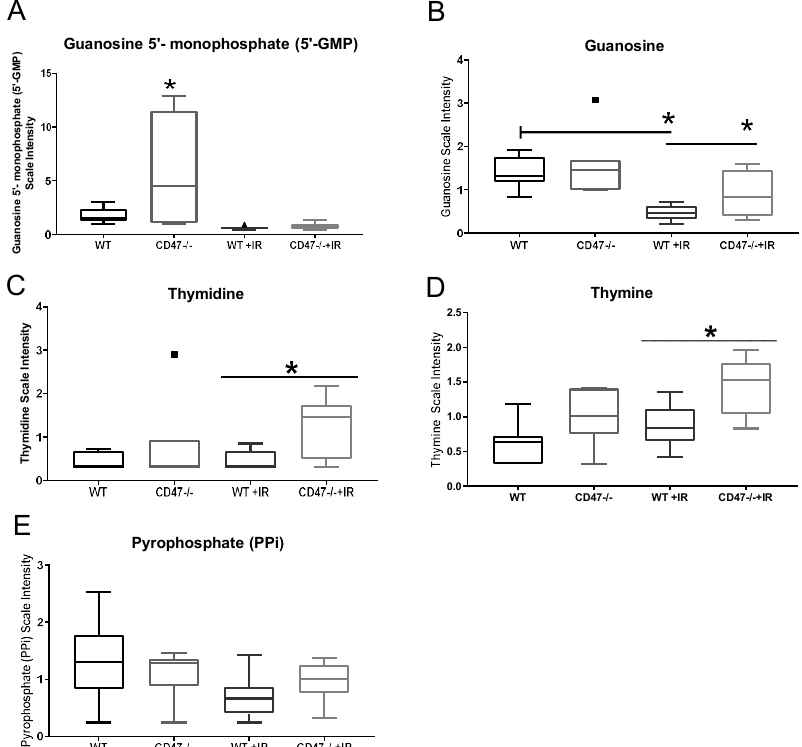
Figure 5. Regulation of nucleotide metabolism. Purines metabolism metabolites ( A ) Guanosine 5’-monophosphate ( B ) Guanosine and Pyrimidine metabolism metabolites ( C ) Thymidine, ( D ) Thymine was measured in lungs of mice exposed to IR. ( E ) Pyrophosphate metabolite levels were measured as a surrogate of nucleotide metabolism activity. Symbols denote outliers. (* p < 0.05, n = 7–8).